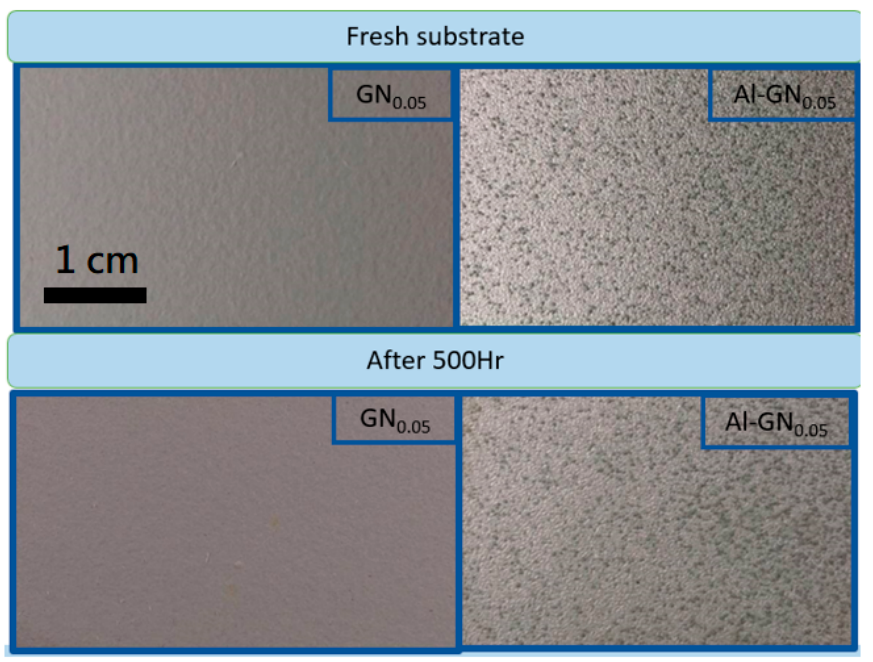
Figure 17. Visual appearances of the coatings with GN 0.05 and Al 25 -GN 0.05 fillers before and after SST. Kirchhoff’s law of thermal radiation states that for an arbitrary body emitting and absorbing thermal radiation in thermal equilibrium, the emissivity ( ε ) and absorptivity ( α ) must be equal. Thus, a good absorber must be a good emitter. Moreover, for opaque objects, α = 1 − R , where R is the reflectivity. Therefore, a good reflector must be a poor absorber/emitter. The high absorptivity of GN fillers inevitably increases the emissivity of the coating. To counteract this harmful effect, we added highly reflective Al pigment in the composite. Figure 18 displays the IR images (with thermal emissivity values) for the pure epoxy, GN 0.05 -epoxy and Al 25 -GN 0.05 -epoxy composites. Note that emissivity is a dimen- sionless number between 0 (for a perfect reflector) and 1 (for a perfect absorber/emitter, i.e., a blackbody). The average emissivity of neat epoxy resin was 0.75 in the 3–5 µ m window and 0.93 in the 8–12 µ m window. These numbers indicate that the epoxy coating absorbs IR very well, and thus has a high emissivity. Note that emissivity ε is the efficiency that a material radiates energy compared to a blackbody. So ε = 1 for a blackbody. If an object has a constant ε (<1), i.e., ε does not depend on wavelength, then it is called a graybody. Most of the real-world objects belong to the third category—selective radiator: their emissivity varies both with wavelength and temperature, i.e., ε = f ( λ , T ). So the emissivity values in 3–5 µ m and 8–12 µ m windows might be quite different in a material. The value of ε also depends on other factors such as surface treatment and material thickness. Adding 0.05 wt.% of GN (1100 ◦ C) in the epoxy raised the IR emissivity to 0.98 and 0.94 in 3–5 µ m and 8–12 µ m, respectively. These increases are due to the high absorption of GN in the IR wavelengths, which is detrimental in the aspect of IR camouflage. After introducing low-thermal-emissivity aluminum powder (25 wt.%) to address this issue, the average emissivity values in the two windows dropped to 0.63 and 0.64, respectively, which were even lower than the blank epoxy coating (by 16% and